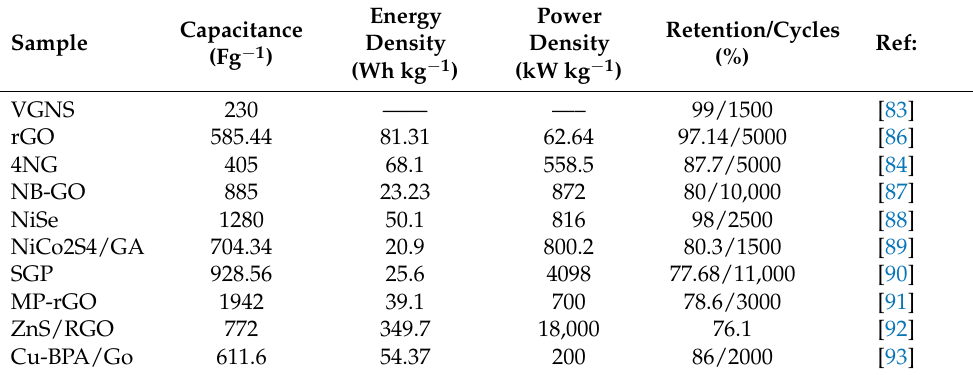
Table 1. The electrochemical performance characteristics of graphene-based carbon electrodes.